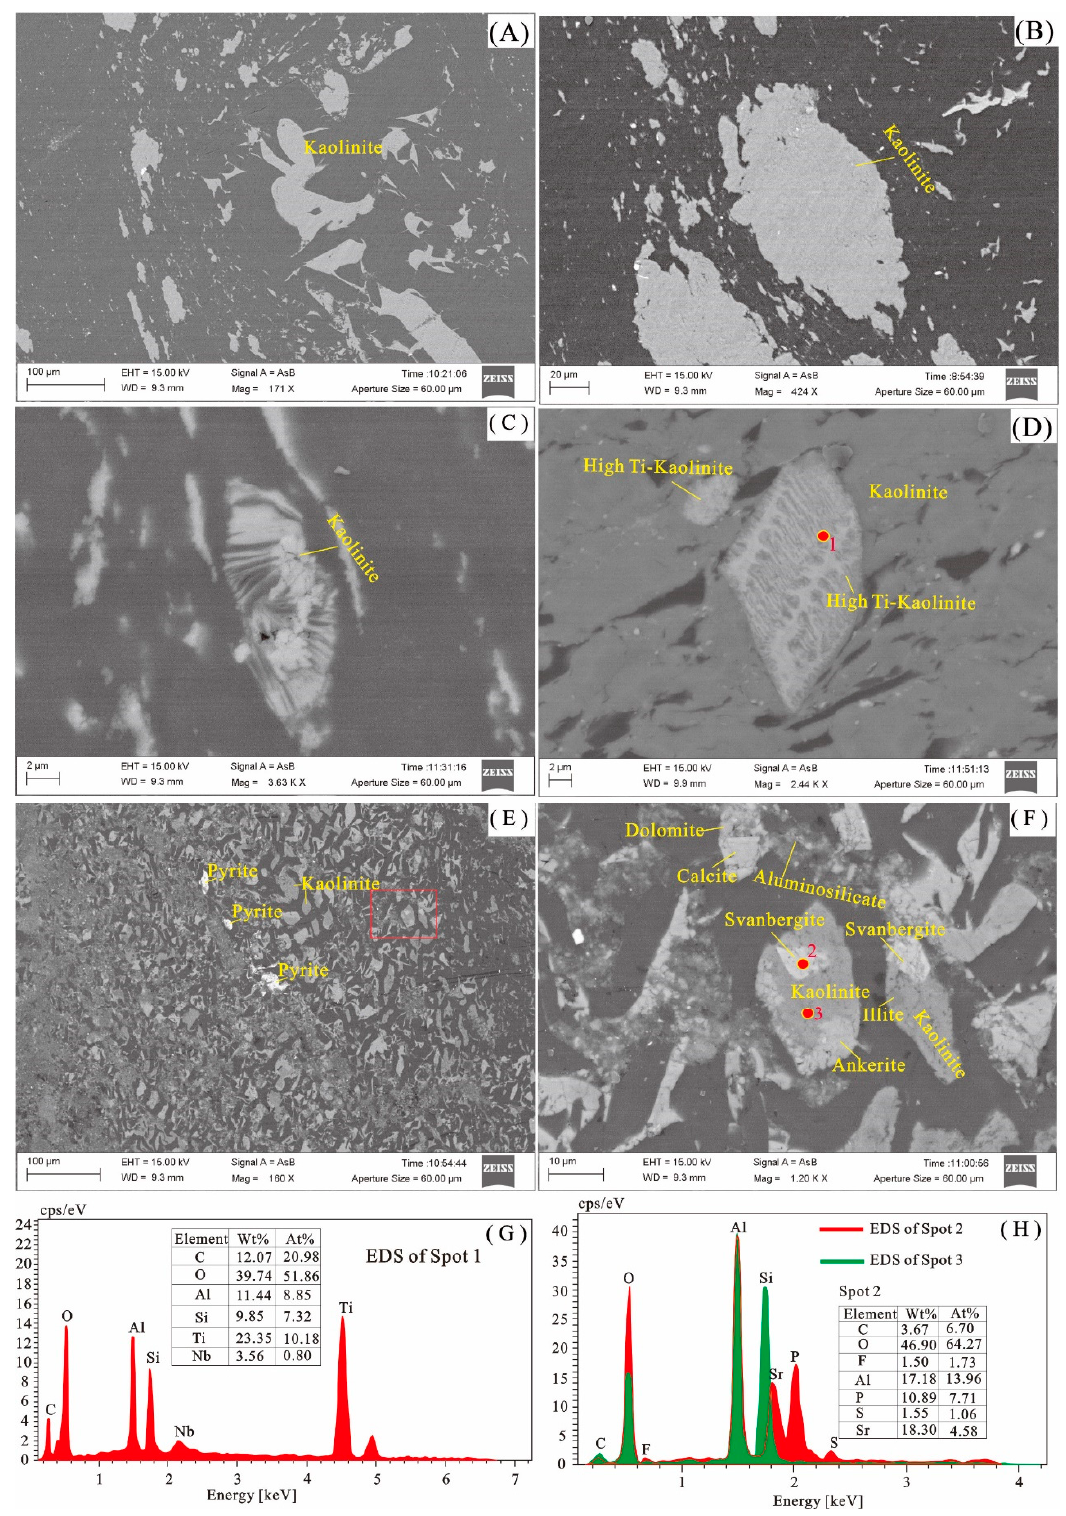
Figure 4. Scanning electron microscope ( SEM) backscattered images of the minerals in the samples from Dongpo Mine. ( A ) Cell-filling kaolinite in sample DP5 -2 -6. ( B ) Lumps of kaolinite in sample DP5 -2 -8. ( C ) Vermicular kaolinite in sample DP5 -2 -5. ( D ) High-Ti kaolinite re-placing plant tissue in sample DP5 -2 -3-p. ( E ) Cell-filling kaolinite and pyrite in sample DP5 -2 -4. ( F ) Kaolinite, illite, svanbergite, calcite, ankerite and dolomite in sample DP5 -2 -4. ( G ) Energy dispersive X-ray spectrometer (EDS) spectrum of Spot 1. ( H ) EDS spectrum of Spots 2 and 3.